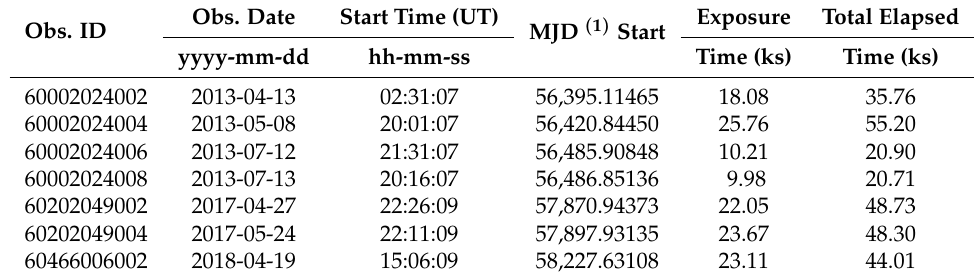
Table 1. Observation log of Nuclear Spectroscopic Telescope Array (NuSTAR) data for TeV HBL Markarian (or Mrk)